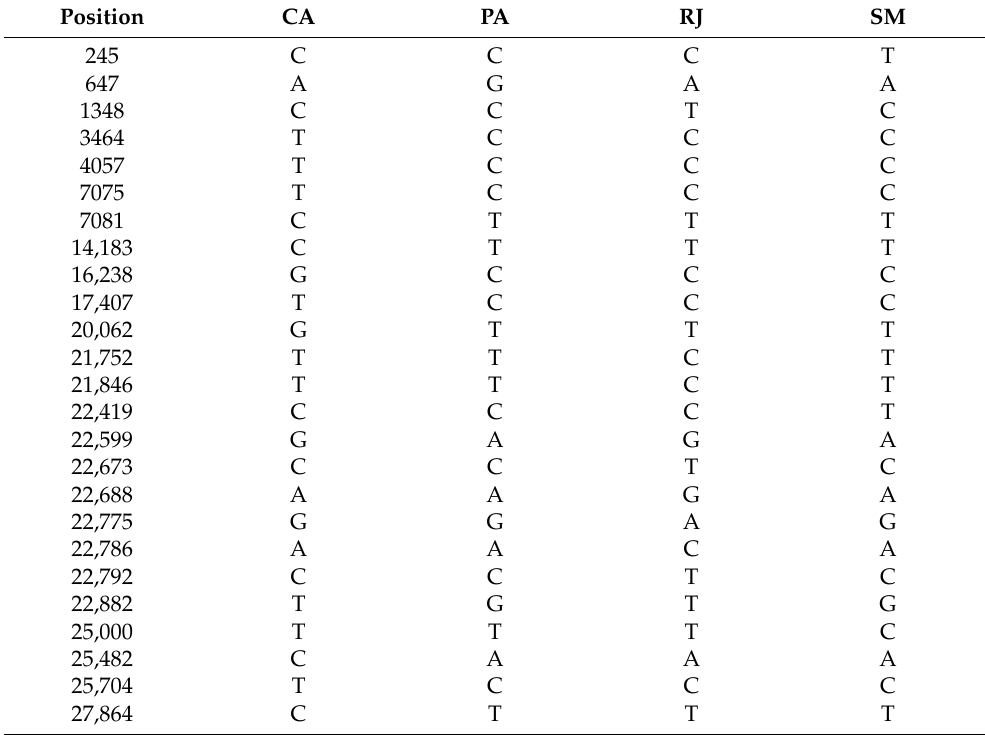
Table A5. SNPs of the AYBA-RS genome sequences. Position